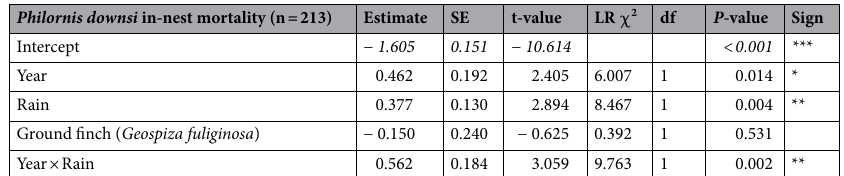
Table 4. Generalized linear model for avian vampire fly ( Philornis downsi ) in-nest mortality in relation to year and rainfall (interaction term); and genus ( Camarhynchus sp. n = 108; Geospiza sp. n = 115), excluding Camarhynchus hybrids. Avian vampire flies collected from Darwin’s finch nests in 10 sampling years over a 17-year period (2004–2020) on Floreana Island. a Genus Camarhynchus sp. ‘tree finch’ was used as a reference category. × indicates an interaction term. Note all quantitative input variables were scaled and centred. Dispersion Parameter for quasibinomial family taken to be 12.421. Intercept presented in italics. Sign = significance levels: ‘***’ < 0.001; ‘**’ < 0.01; ‘*’ < 0.05.